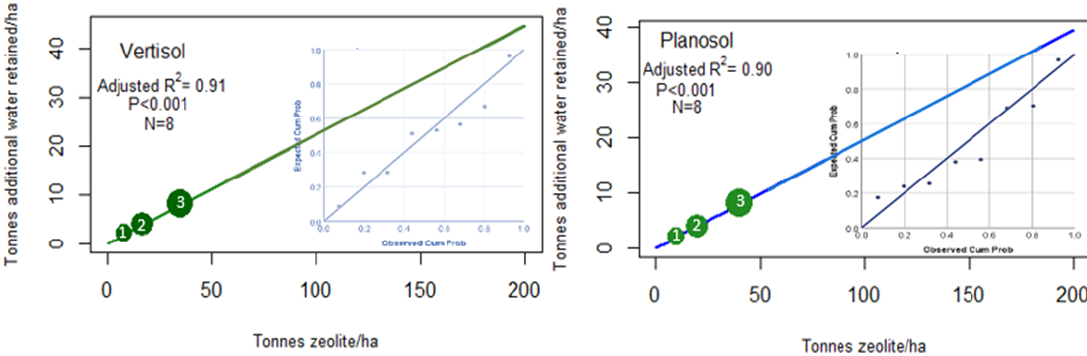
Figure 3. Example of how zeolite additions affect water retention for two soil types—Vertisol and Planosol—under drought conditions. Linear regression models applied to data from Kingston [13]. See methods for experimental details. Model fits plotted as insets for each soil type. Estimated tonnes of additional water provided by zeolite amendments derived using model outputs and assuming bulk density values of 1.6 t/m 3 for Vertisol [15] and 1.1 t/m 3 for Planosol [14], using a reference point of zero for soils with no zeolite amendments. Points ‘1,’ ‘2,’ and ‘3’ represent soil moisture quantities needed to support 1.25×, 1.5×, and 2× typical crop yields of 2 t/ha, reported by Anderson et al. [104], at average plant moisture content of 85% [105].